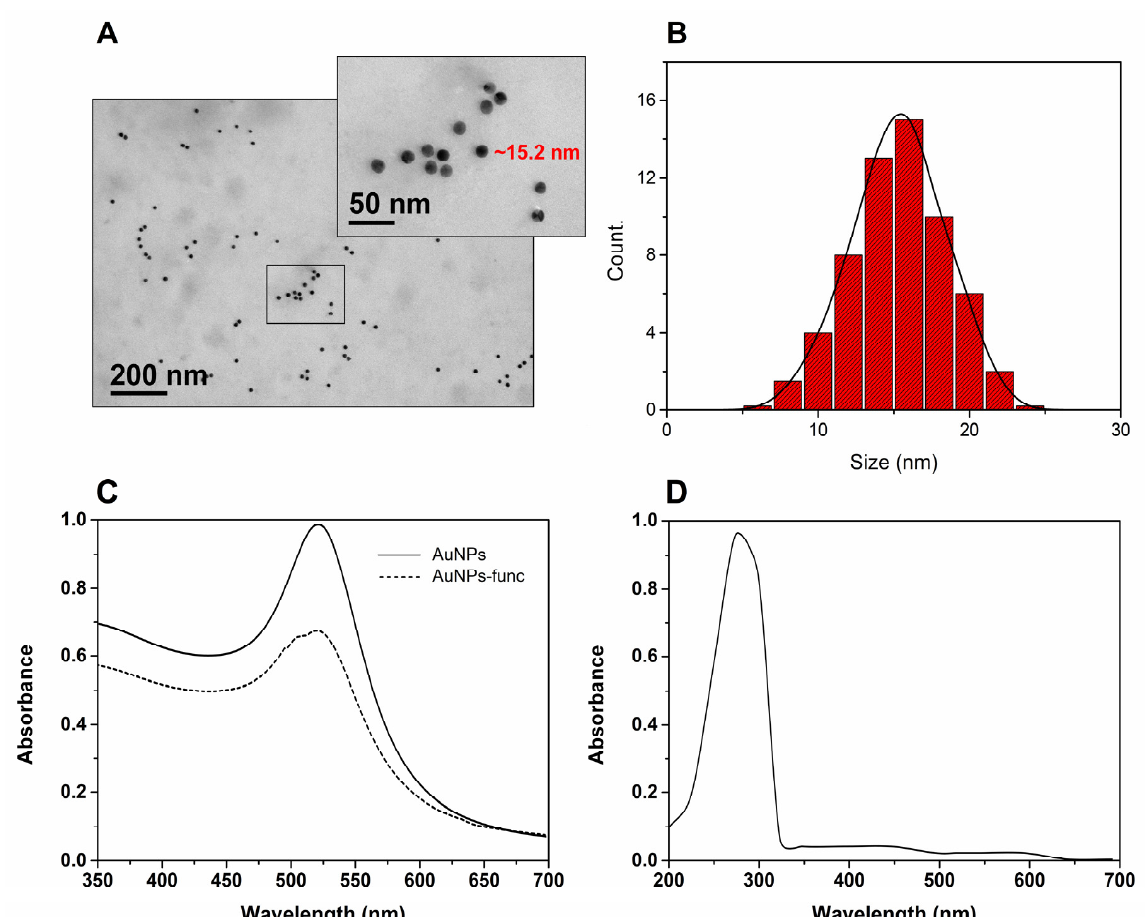
Figure 5. ( A ) TEM image of AuNPs indicating distribution with scale bar magnification: 200 nm and 50 nm. ( B ) Particle size distribution histogram determined from the TEM image. ( C ) UV–Vis spectrum indicates the absorbance changes between the AuNPs (solid line) and the functionalized AuNP-Oligos (dashed line). ( D ) UV–Vis spectrum indicates the displacement of the SPR band after hybridization of the target amplicon with AuNP-Oligos, evidencing the detection of SARS-CoV-2.